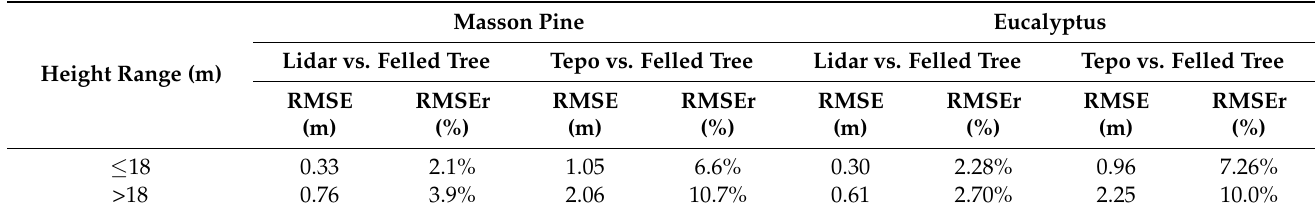
Table 5. Evaluation of measured tree height results based on different height ranges.